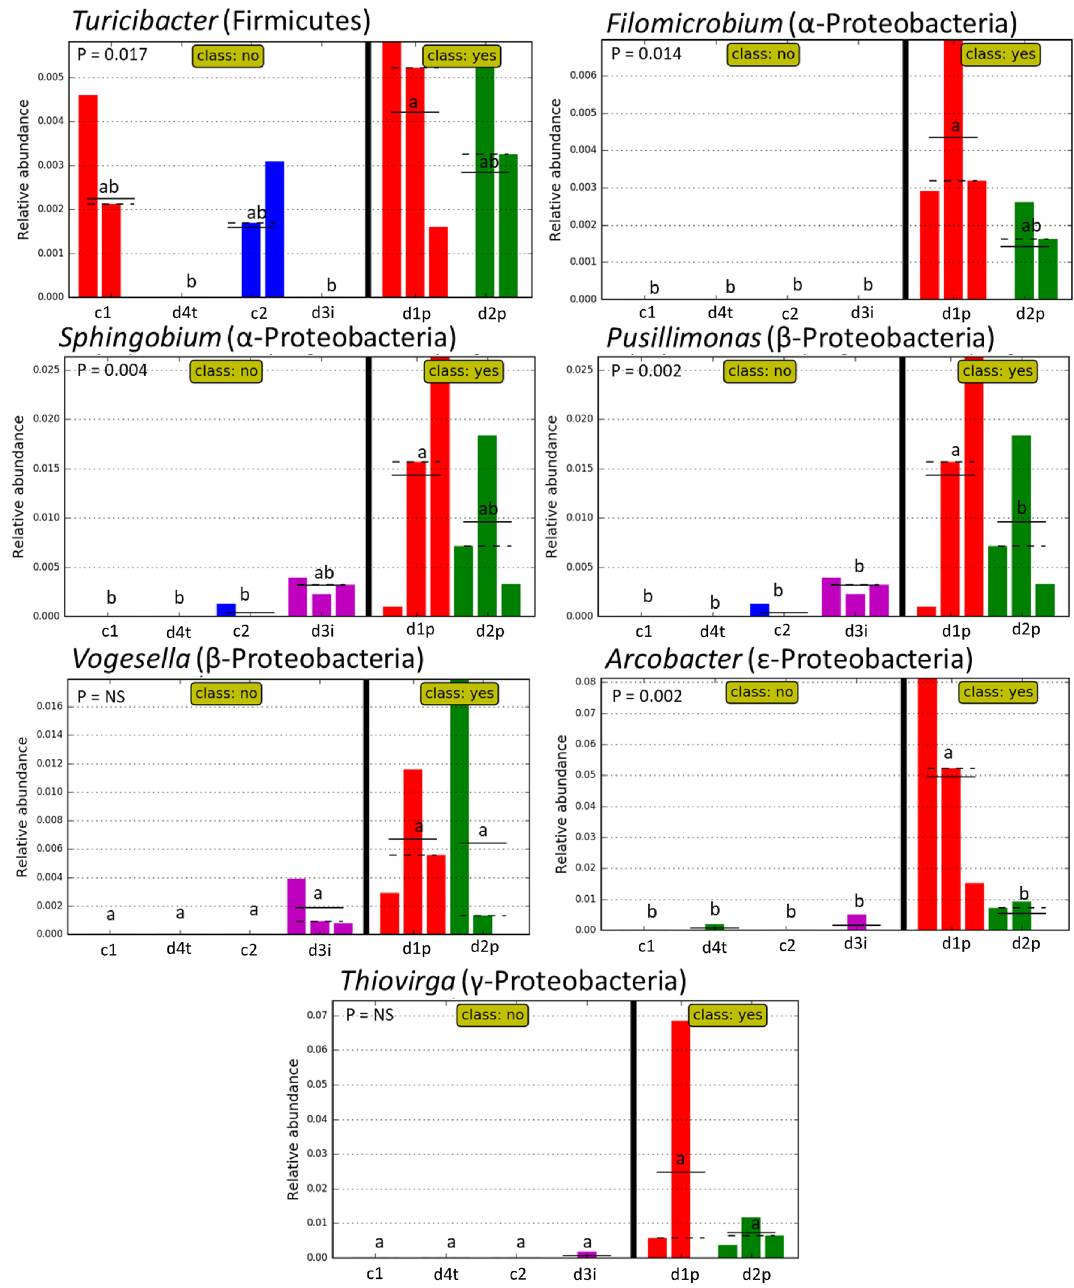
Figure 4. Histograms generated following LEfSe analysis showing relative abundance of genera identified as potentially indicative of preservation. Class shows if samples are within area of observed good preservation. P values are listed in corner of each figure. NS non-significant. Tukey’s test within each graph is represented by letters. Layers which share letters are not significantly different from each other 15